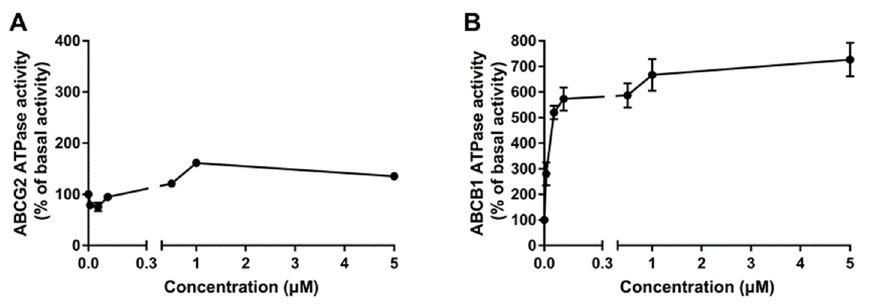
Figure 5. Poziotinib significantly stimulates ABCG2 and ABCB1 ATPase activity. ( A ) The effect of poziotinib on the ATPase activity of the ABCG2 transporter. ( B ) The effect of poziotinib on the ATPase activity of the ABCB1 transporter. Data are expressed as the mean ± SD derived from three independent experiments.